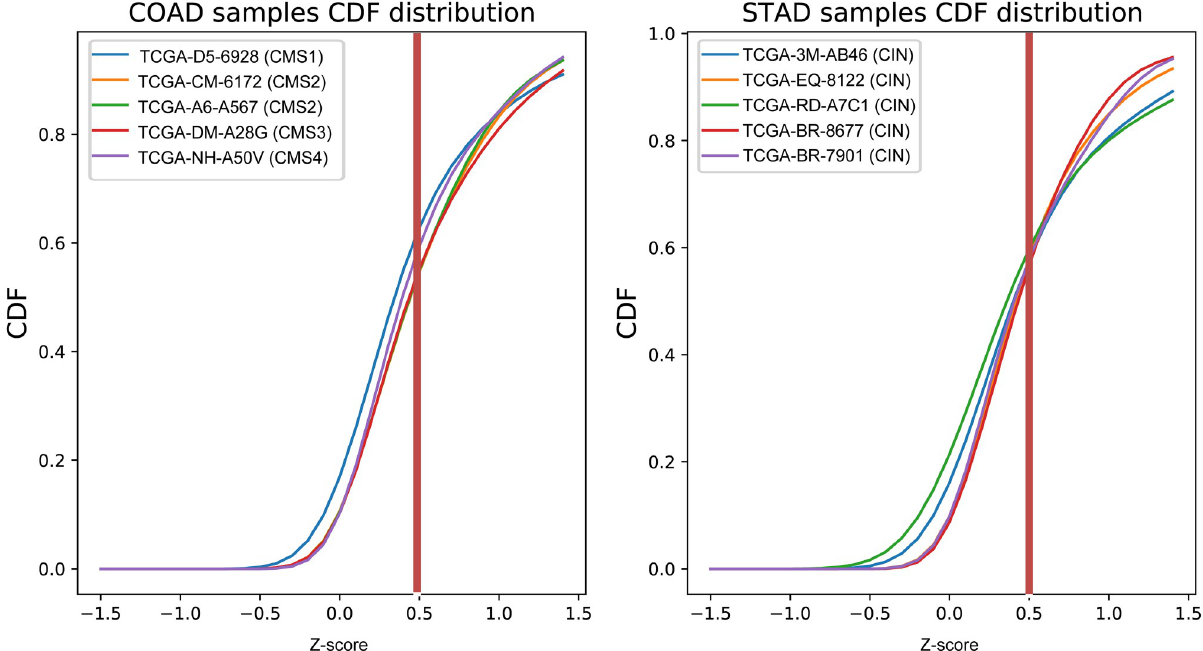
Fig 4. The CDF plots of a set of randomly selected STAD and COAD samples. Five samples were randomly selected for which the CDF plots were visualized. The horizontal line at 0.6 indicates the CDF threshold, that is used as the criteria for feature selection.